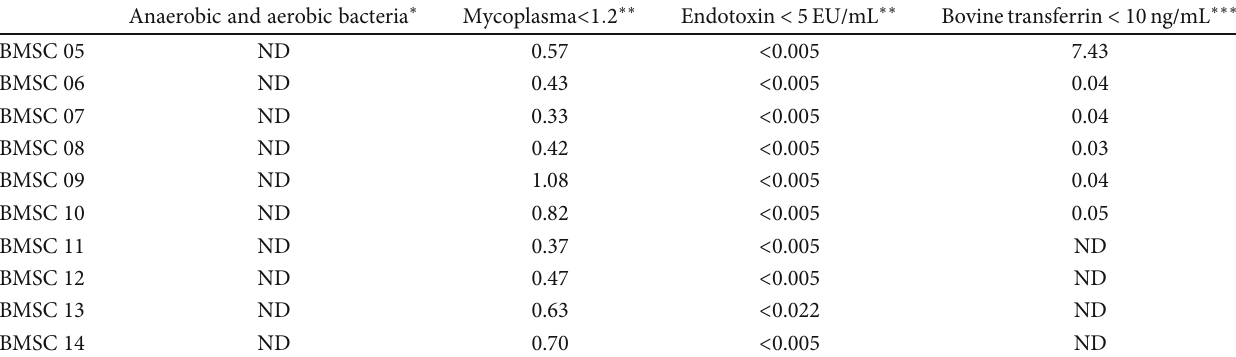
Table 4: Purity and safety analysis of the